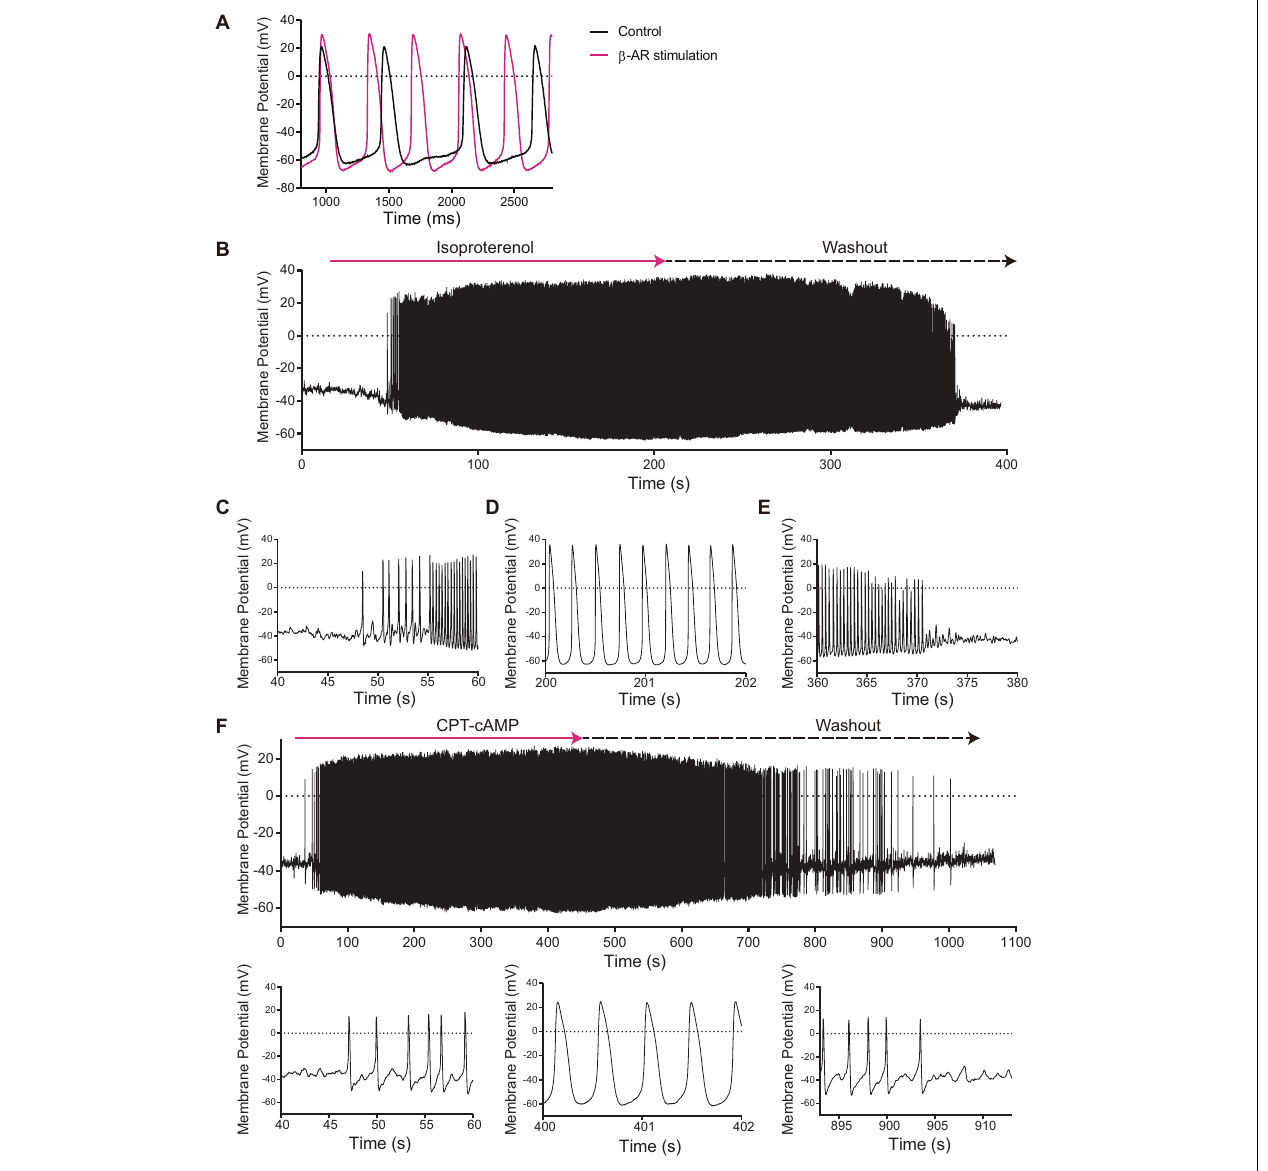
FIGURE 3 | (A) Membrane potential tracings of SANC that fire spontaneous APs at baseline (black) that accelerated in response to isoproterenol (magenta). (B) Among 12 initially dormant SANC, 44% fired APs in response to β -AR stimulation (“responder”) while 56% failed to do so (“non-responder”). This was significantly different from the corresponding time control group ( n = 8) in which spontaneous AP firing did not occur ( p < 0.05).) When isoproterenol was washed out, the β -AR stimulation-induced APs stopped. Detail of the beginning (C) , steady state (D) and wash-out (E) phases of the β -AR stimulation-induced AP in a SANC that was dormant under initial baseline conditions. (F) The cell permeable CPT-cAMP recapitulated the β -AR stimulation-induced APs in other set of SANC that were dormant at baseline. Note the similarity to panel (B–E) .